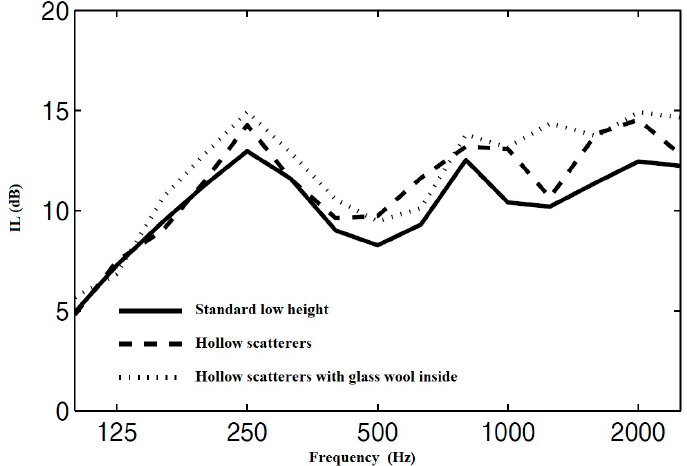
Figure 11. Insertion loss of low-height barrier in different cylinder settings, modified from [65].